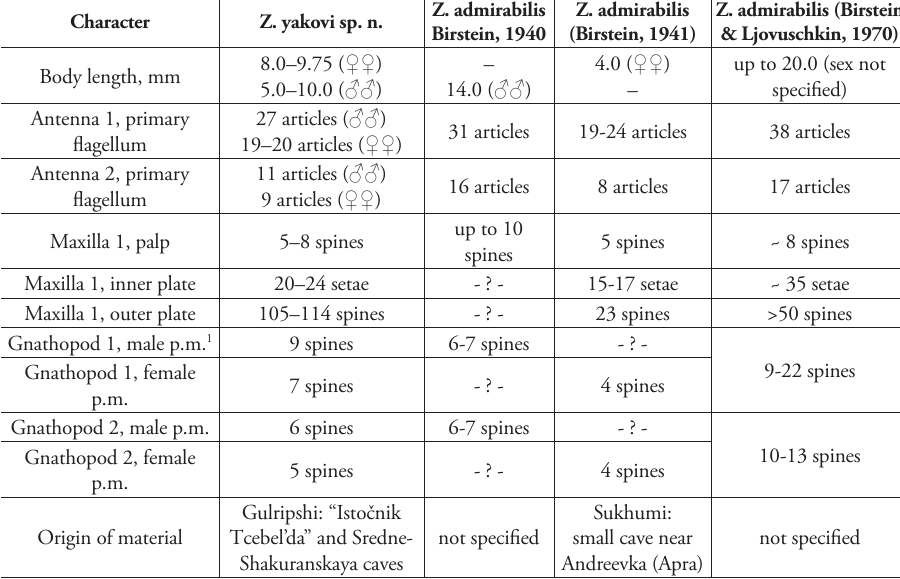
Table 1. Variation in morphological characters in adult specimens of Zenkevitchia yakovi sp. n. and comparison with published data for Z. admirabilis